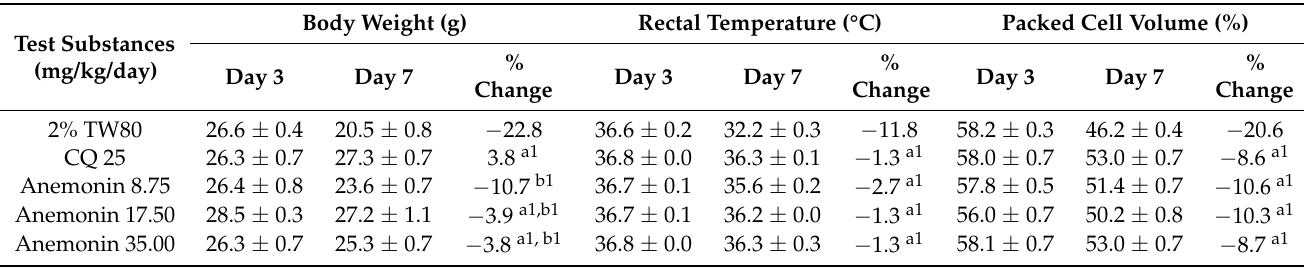
Table 7. Body weight, rectal temperature, and packed cell volume of Plasmodium berghei -infected mice treated with anemonin in Rane’s antimalarial test.